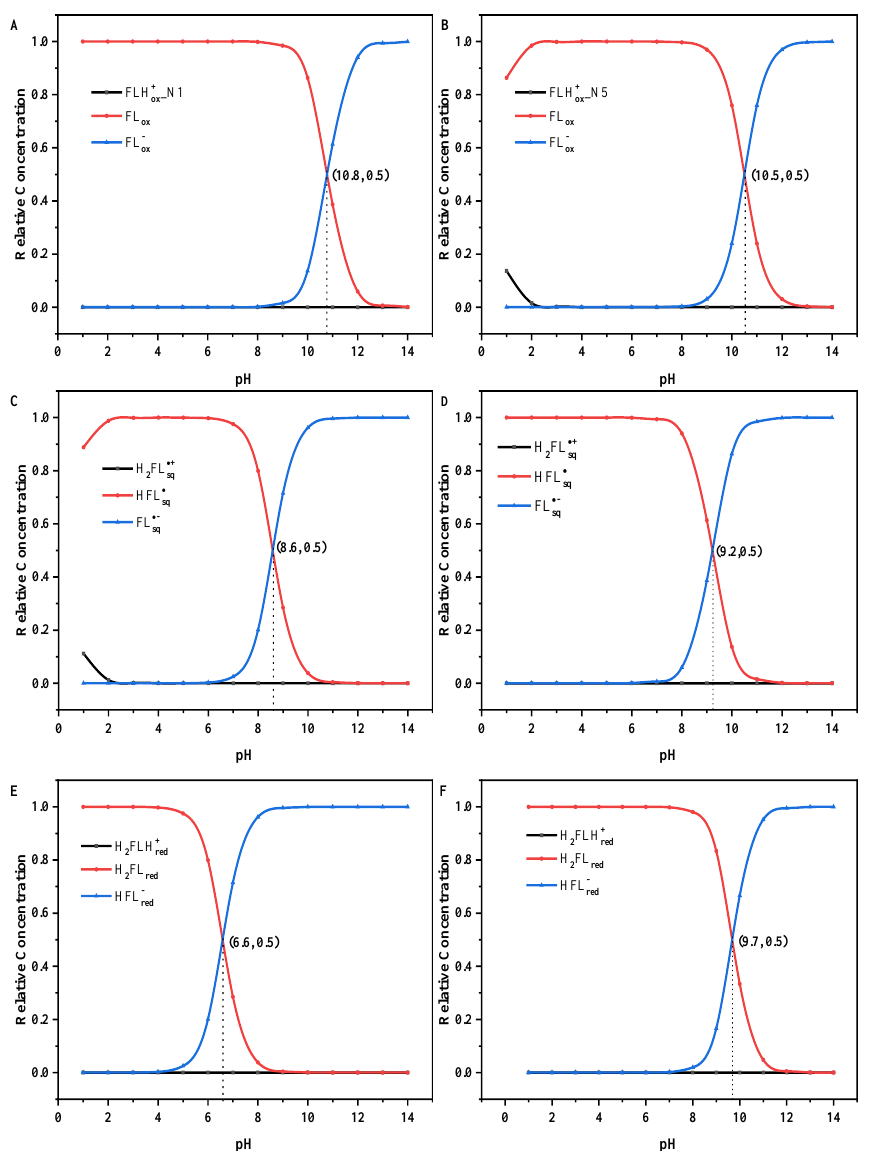
Figure 4. The diagrams of relative concentrations for the S 0 state ( A , C , E ) and S 1 state ( B , D , F ) of different forms of flavins in aqueous solution at different pH values.